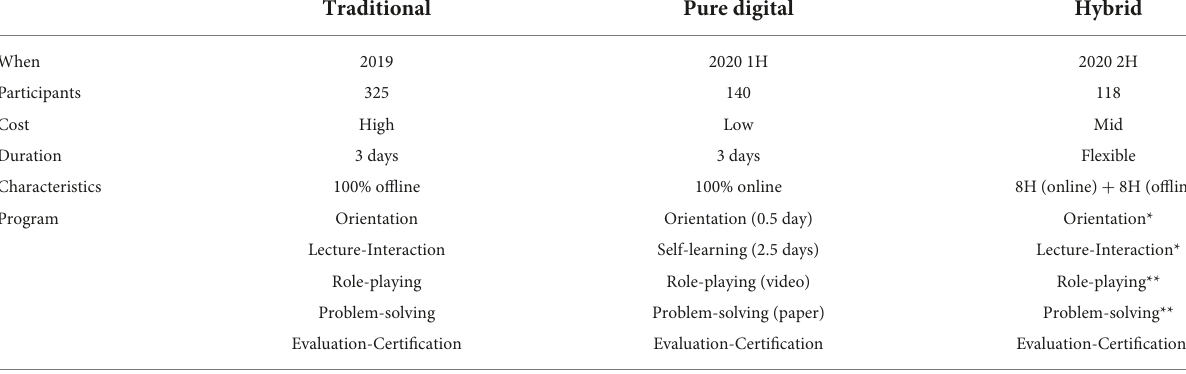
TABLE 2 Comparison: traditional, pure digital, and hybrid